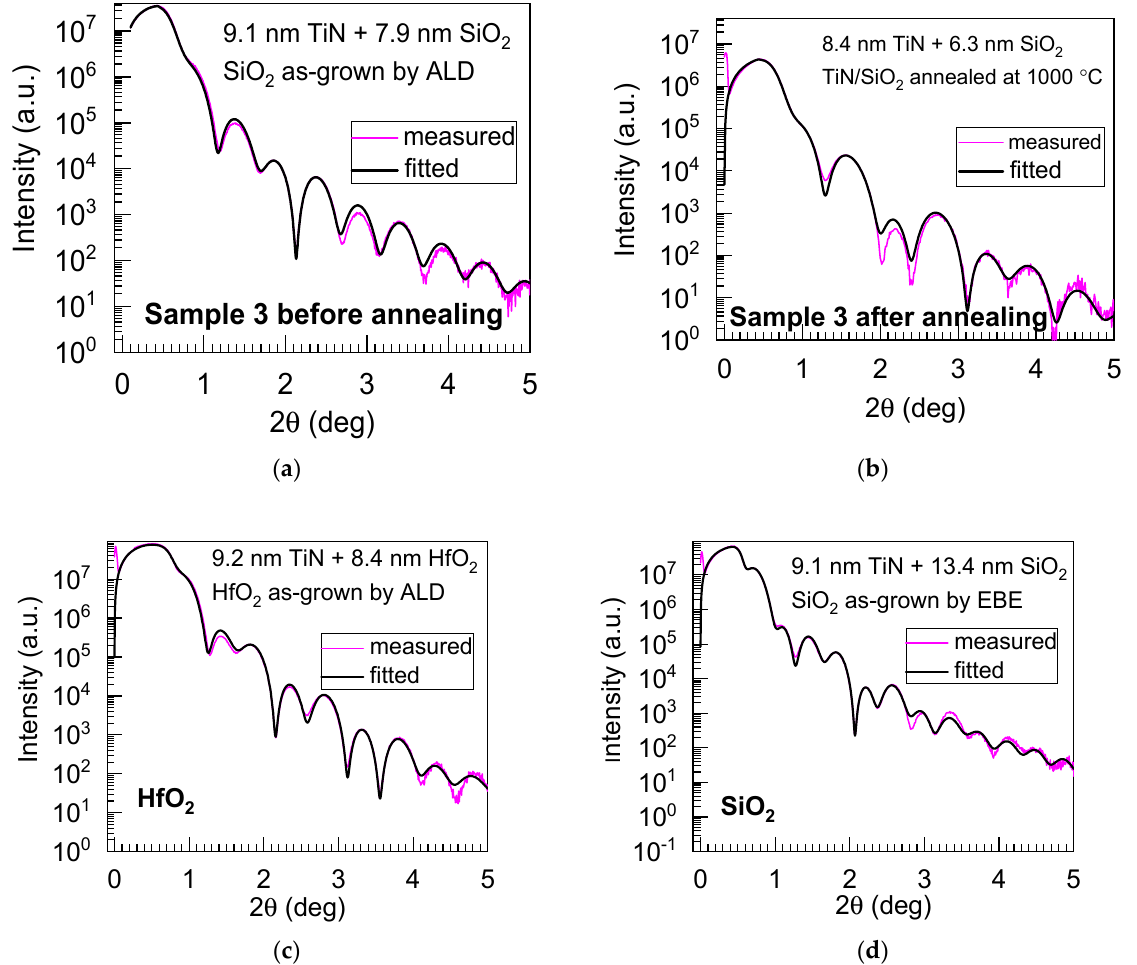
Figure 4. Measured and modeled X-ray reflectivity curves from SiO 2 film, as grown by ALD ( a ), ALD-grown SiO 2 annealed at 1000 ◦ C ( b ), ALD-grown HfO 2 ( c ), and EBE-grown SiO 2 ( d ) on Si/TiN substrates. For the description of samples, see Table 1.